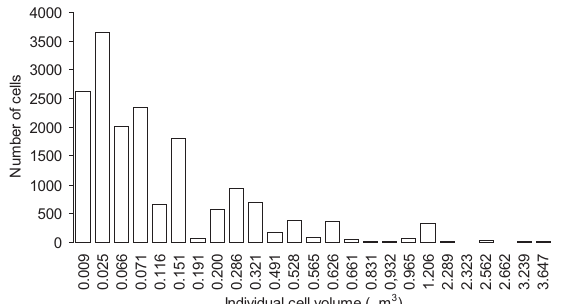
Fig . 5. – distribution patterns of the total number of bacteria counted in all samples (n=16 976) and their measured volumes.